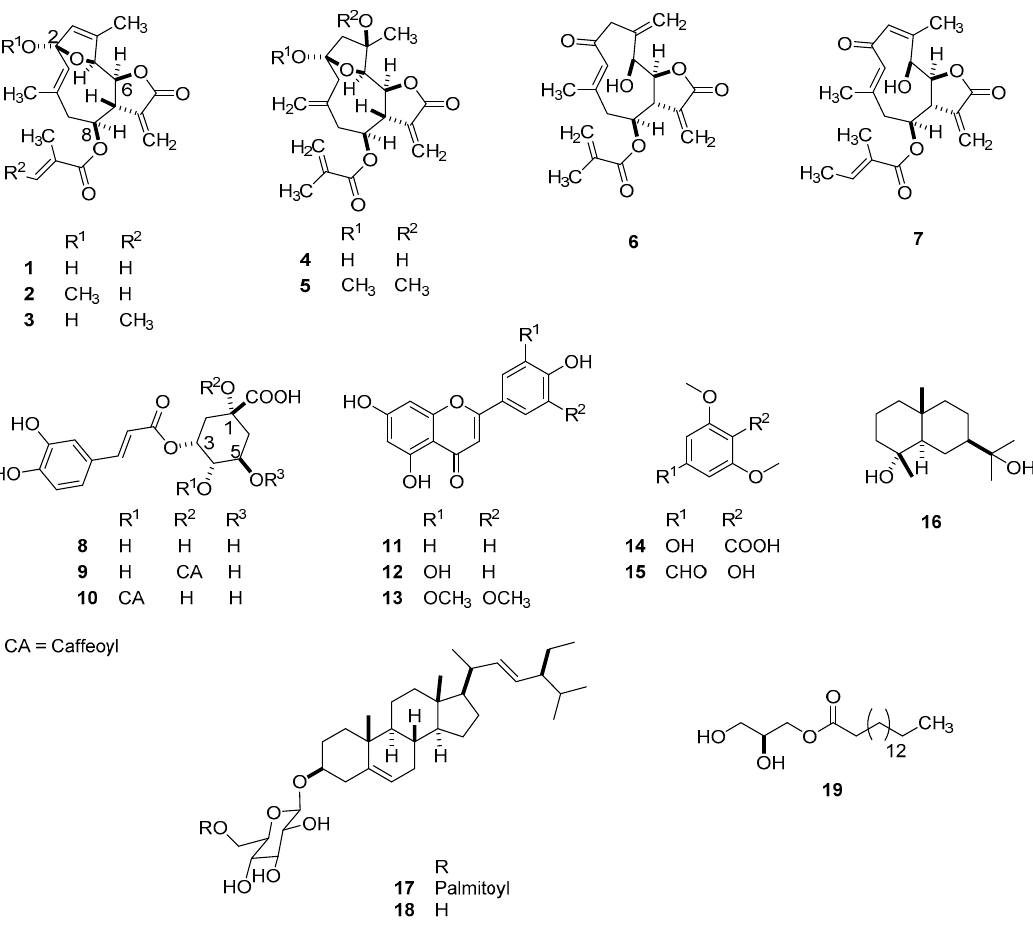
Figure 1. Structures of isolated compounds 1 – 19.